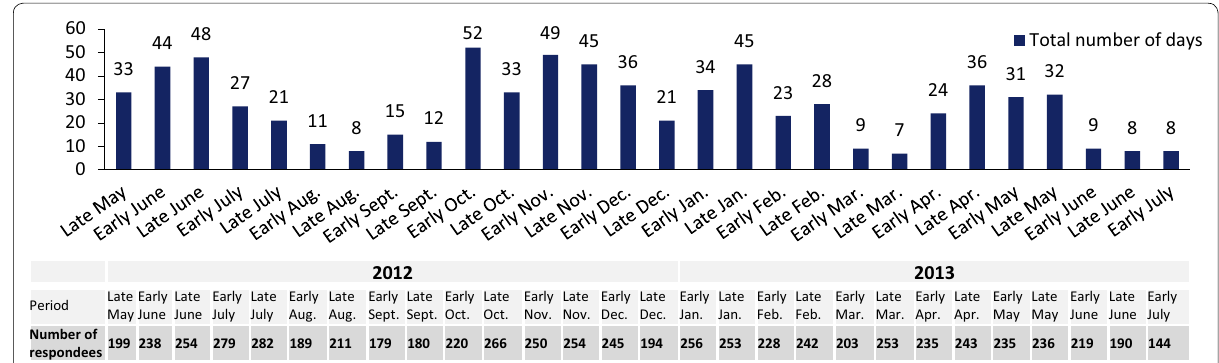
Fig. 5 Fortnightly telephone interviews of study participants: total number of days off work in each fortnightly period ( n